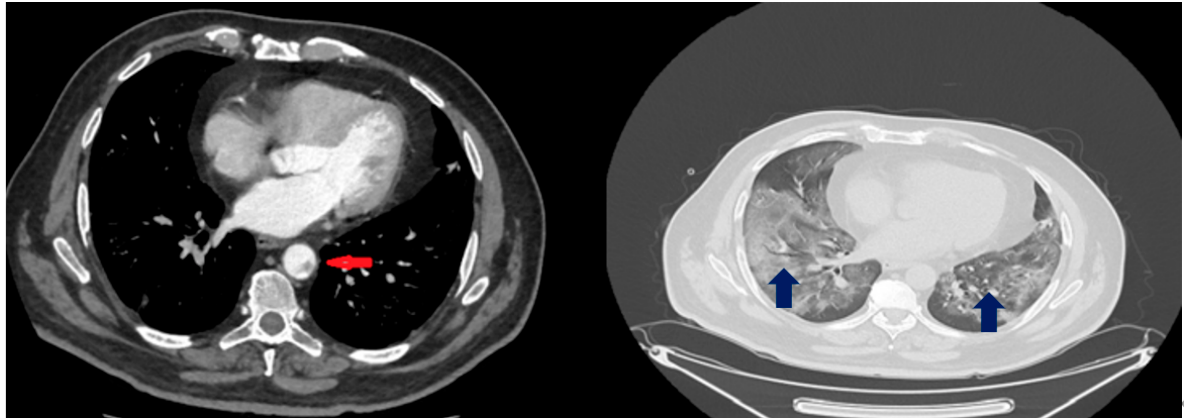
Figure 1. CT pulmonary scan of the patient at day 6. The blue arrows demonstrate bilateral ground glass opacities and regions with pulmonary consolidation. The red arrow indicates the thrombi detected in the thoracic aorta.